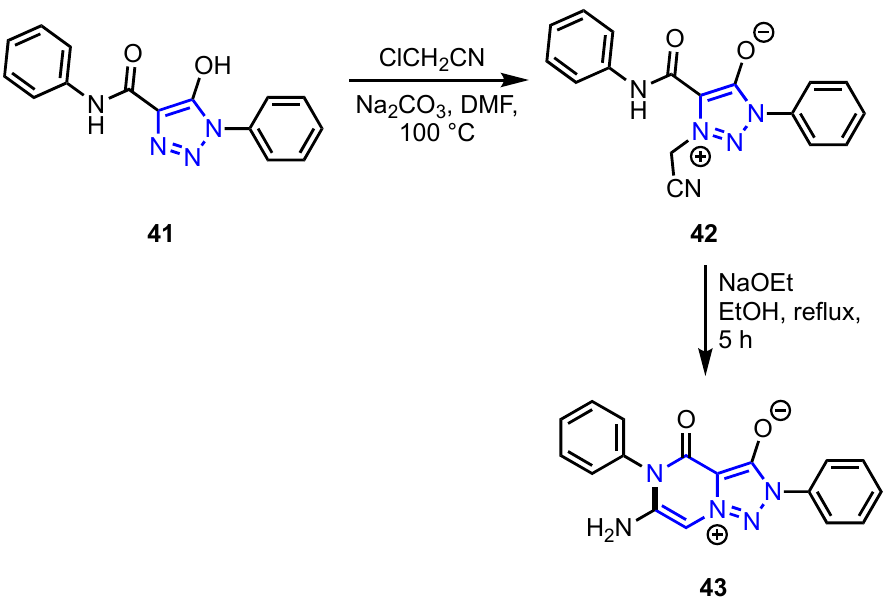
Scheme 9. Intramolecular cyclization of a triazolium salt 42 , forming zwitterionic 43 .